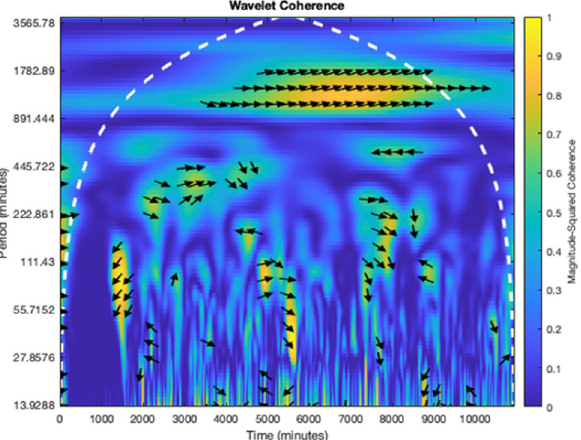
Figure 1. Cross-wavelet transform. Results of cross wavelet transform for the pair of signals x ( t ) and y ( t ) were obtained using Morlet wavelet with ω 0 = 2π. Patterns of sleep and glucose were associated with time- and frequency-dependent coherence between these two processes and are represented as a heat map